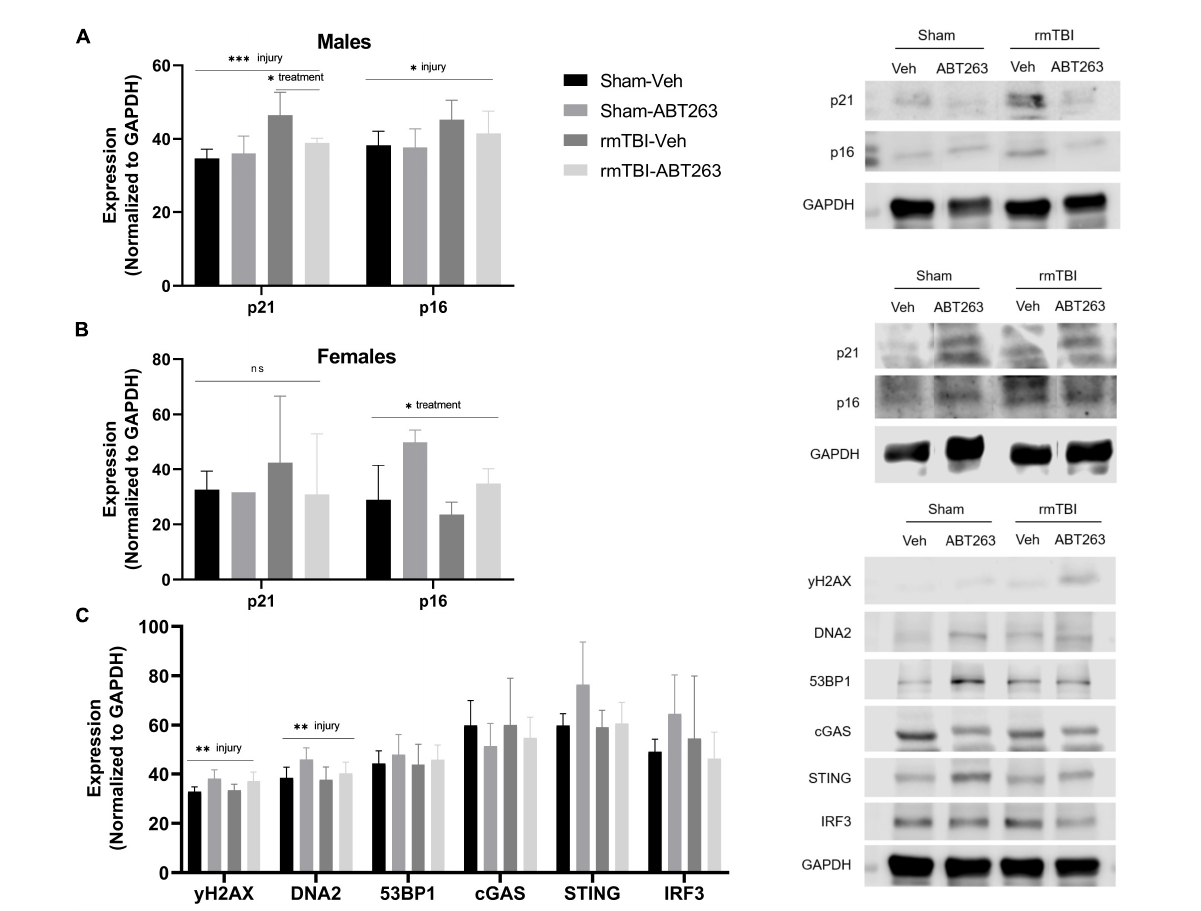
FIGURE7 Treatment with senolytic drug ABT263 reduces senescence in males, but not females, following rmTBI. Western blot analysis revealed that ABT263 treatment 1 week after injuries followed by sacrifice 1 week later (total of 2 weeks post-injuries) significantly reduced expression of p21 in male rmTBI mice (A) ( p = 0.02, two-way ANOVA), which was significantly increased by injury ( p = 0.0003, main effect of injury, two-way ANOVA). p16 was also significantly increased by injury ( p = 0.02, main effect of injury, two-way ANOVA) in the males (A) and was only partially reduced by ABT263 treatment, although this did not reach statistical significance. In contrast, females showed no significant differences in p21 protein levels by this timepoint (B) . Interestingly, p16 protein levels significantly increased with ABT263 treatment in female mice ( p = 0.03, main effect of treatment, two-way ANOVA). ABT-263 treatment did not significantly reduce markers of DNA damage nor cGAS-STING signaling (C) in male mice, indicating the remaining presence of DNA damage and inflammatory signal. Error bars represent standard deviation with n = 4 per group. Statistical significance is marked as ∗ p < 0.05, ∗∗ p < 0.01, ∗∗∗ p < 0.001. ns, not